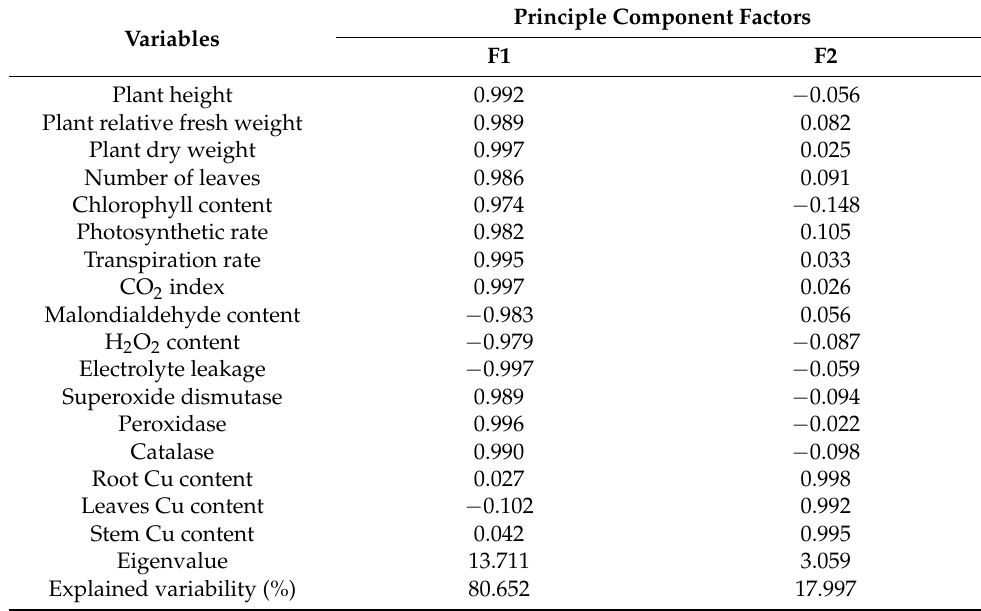
Table 3. Correlation coefficients among variables and principal components